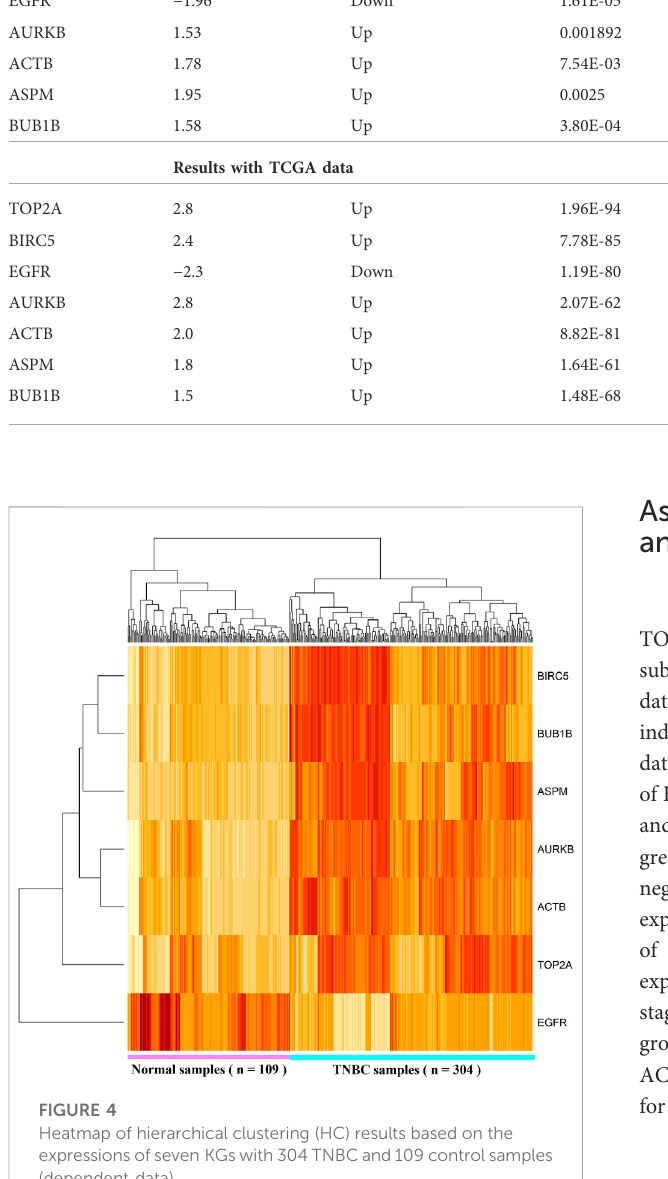
GO and KEGG enrichment analysis showed that our identi fi ed DEGs were enriched by 63 BP-terms, 14 CC-terms,